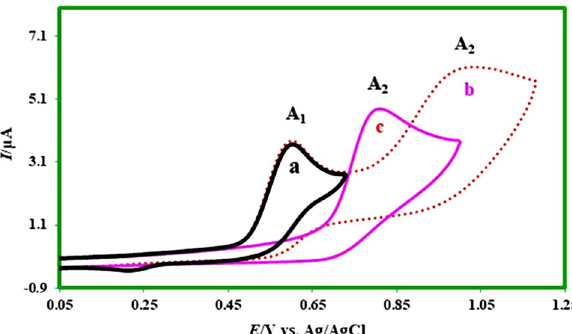
Figure 10. Cyclic voltammograms for a solution of (a) 0.4 mM MFA (b) 0.4 mM MFA in the presence of 0.4 mM sodium nitrite (c) 0.4 mM sodium nitrite at a glassy carbon electrode, in phosphate buffer solution